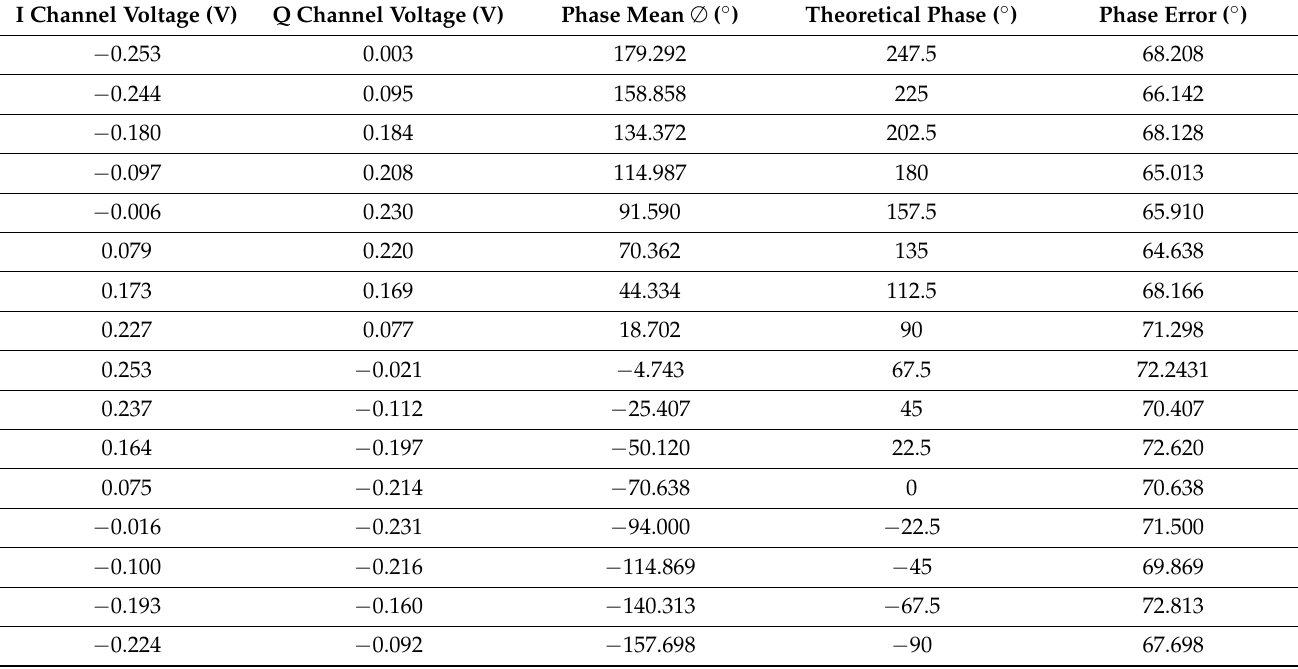
Table 2. Sampling data during phase